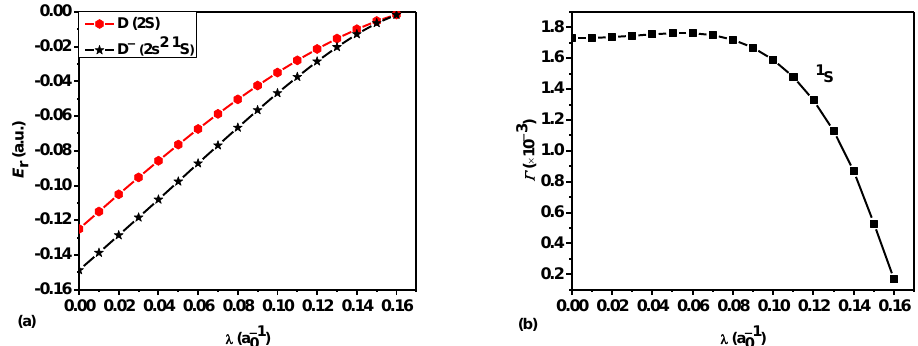
Figure 7. ( a ) Lowest 1 S e resonance energy 𝐸 𝑟 of D − versus 𝜆 . ( b ) Corresponding resonance width 𝛤 of D − versus 𝜆 .